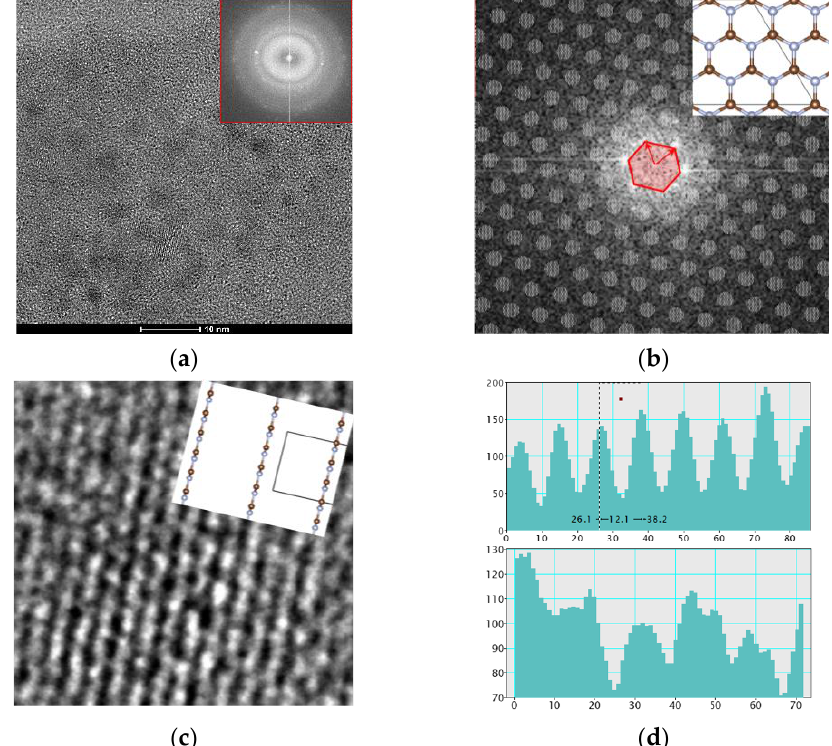
Figure 3. TEM observations on the NG film nanostructures: ( a ) TEM image, ( b ) FTT image, ( c ) lattice stripe, ( d ) lattice spacing of g-C 3 N 4 .